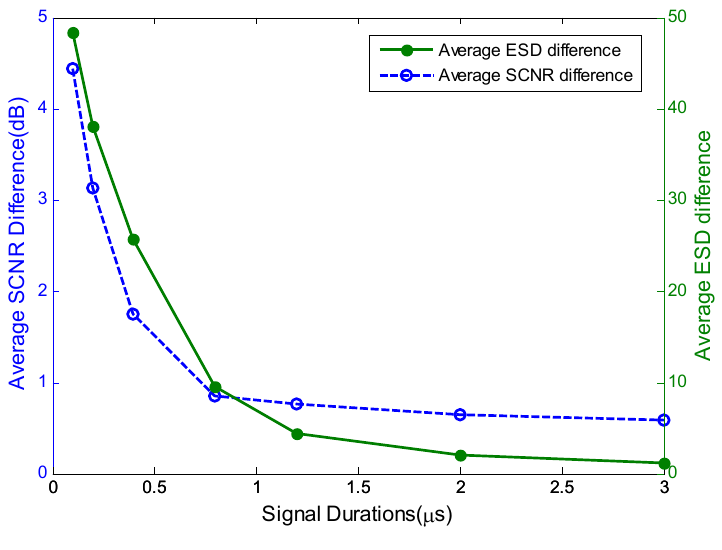
Figure 6. Average ESD difference and SCNR